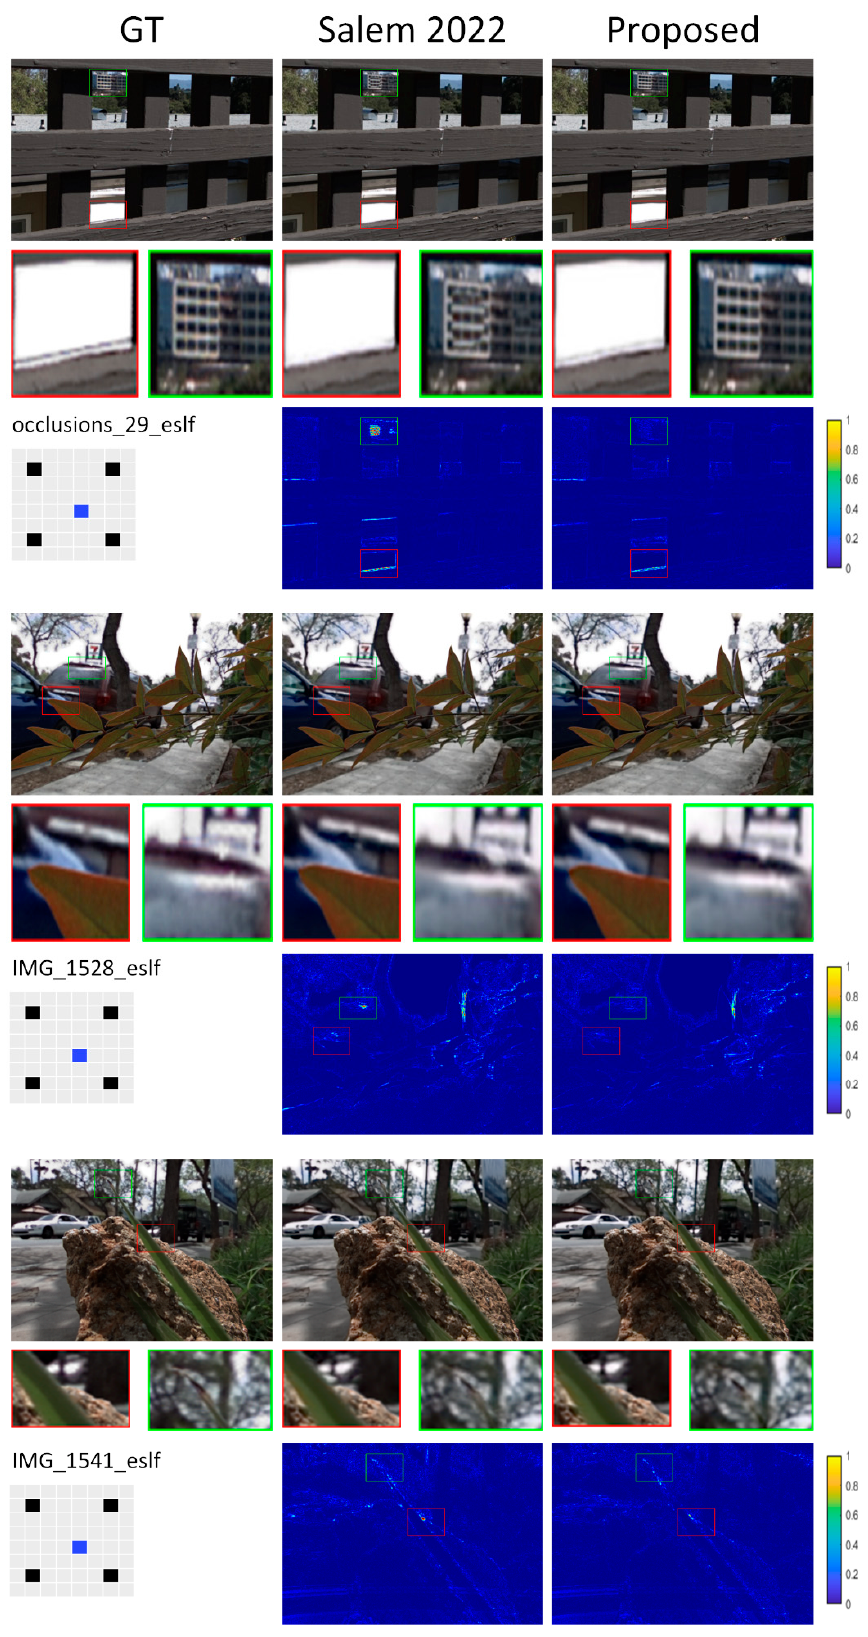
Figure 7. Visual comparison of the proposed model to reconstruct 8 × 8 views out of 2 × 2: extrapo- lation 1 at an interpolated view.